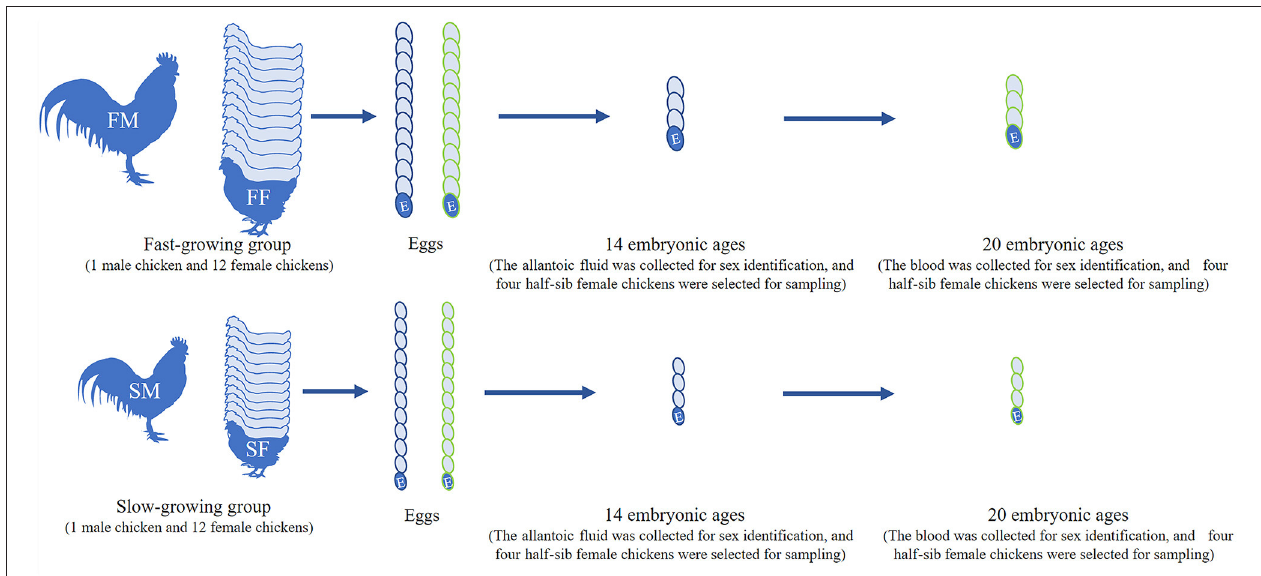
FIGURE 1 | Workflow of sample selection. FM, fast-growing male chicken; FF, fast-growing female chicken; SM, slow-growing male chicken; SF, slow-growing female